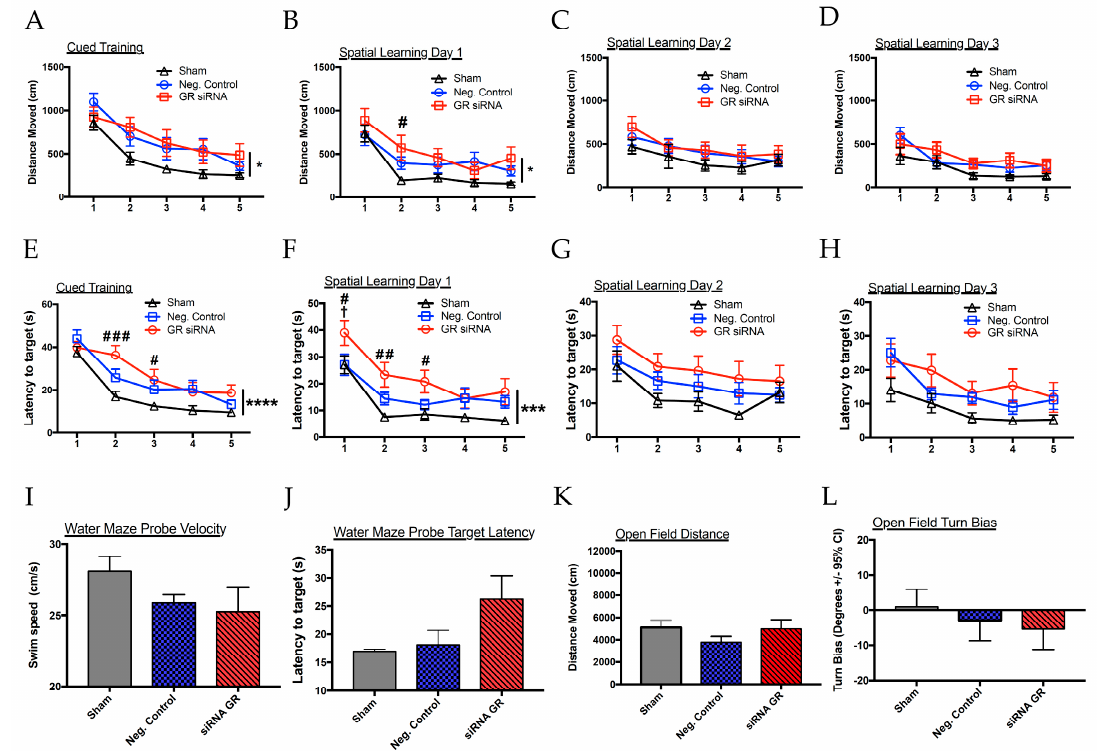
Figure 7. Repression of GR and long-term neurobehavioral deficits in the neonatal male rat with mild HI injury. The neonatal male rats received GR siRNA (100 pmol) or negative control (100 pmol) by ICV injection 48 h before HI-injury (8% FiO 2 ; 60 min). Groups were sham (negative Control; ( n = 12) versus negative control with HI injury ( n = 13) versus GR siRNA ( n = 11) with HI injury. ( A – D ) Morris water maze cued training to spatial learning day 3 testing for the distance moved before arrival to the platform. ( E – H ) Cued training to spatial learning day 3 for the latency to platform in seconds. ( I , J ) Probe trials performed before Spatial 2 and 3. ( K,L ) Open-field test. * p < 0.05, *** p < 0.01 , **** p < 0.001, two-way ANOVA group (sham vs. negative control vs. GR siRNA) effect. # p < 0.05, ## p < 0.01, ### p < 0.001 sham vs. GR siRNA. † p < 0.05, negative control vs. GR siRNA.